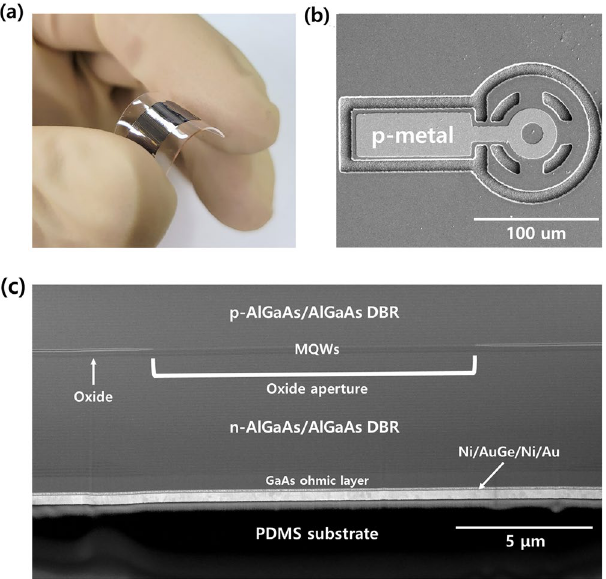
Figure 4. Fabrication of the top-emitting 930 nm thin-film VCSELs. ( a ) An actual image of the fabricated flexible thin-film VCSELs transferred onto PDMS, ( b ) top-view and ( c ) cross-sectional FE-SEM image of the fabricated thin-film